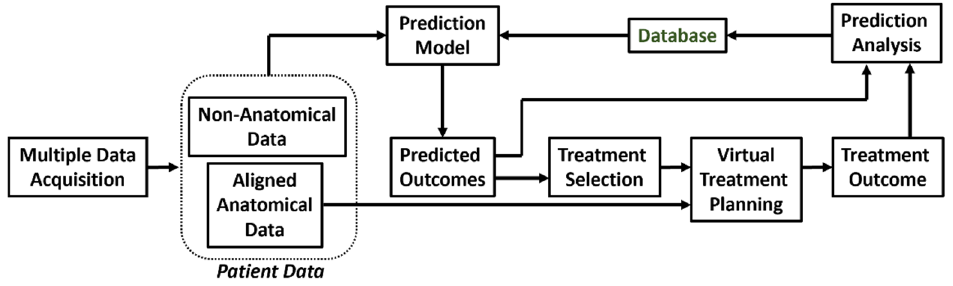
Figure 5. Schematic diagram of prediction based VSP.